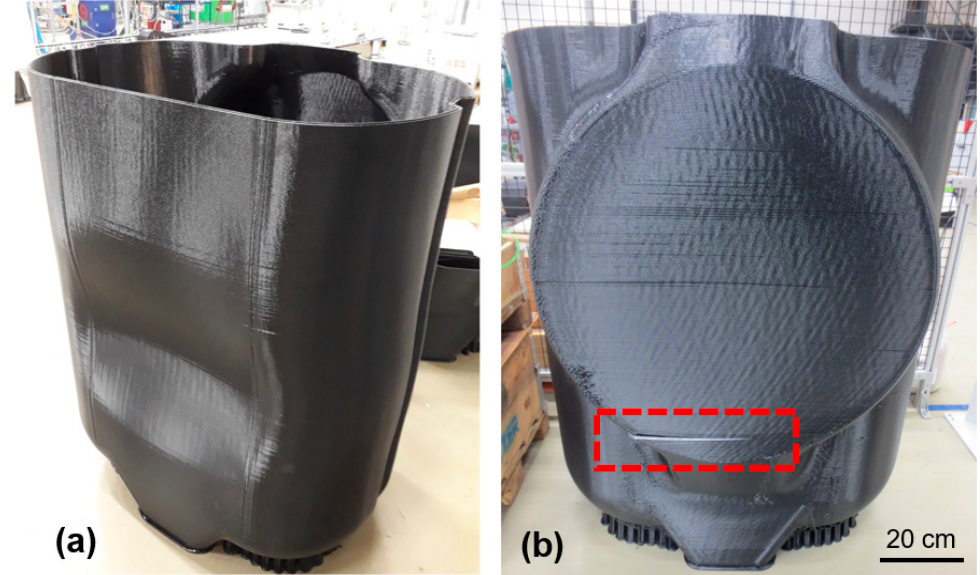
Figure 2. Manufacturing defects in a fuel tank printed from pure ABS using IRBAM. ( a ) Warpage and buckling in front side. ( b ) Cracking in the back side.